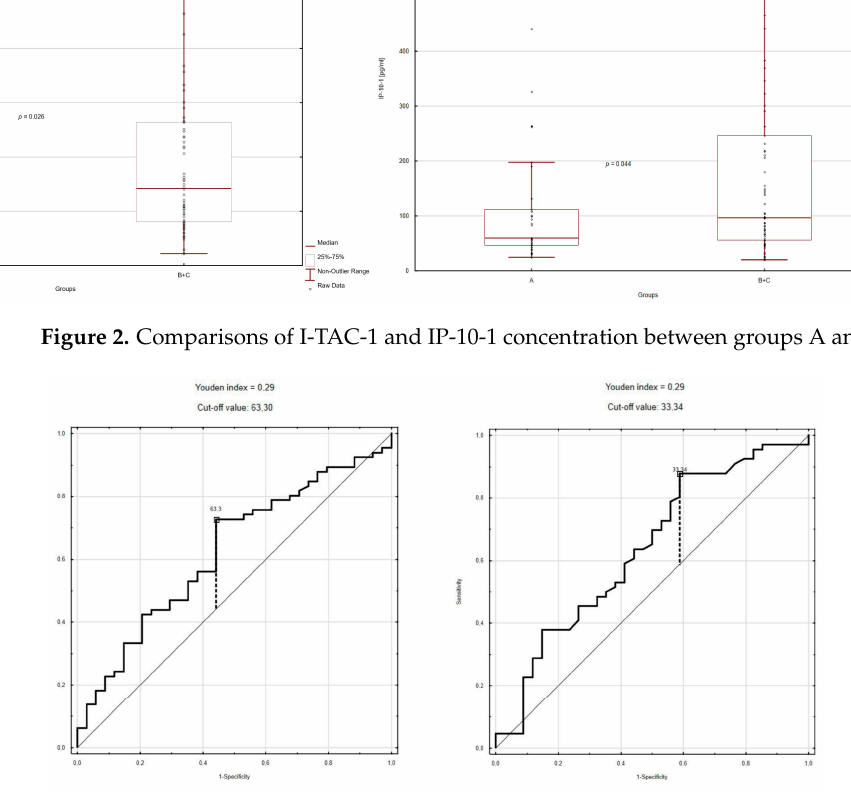
Figure 3. Receiver operating characteristics curves of I-TAC-1 and